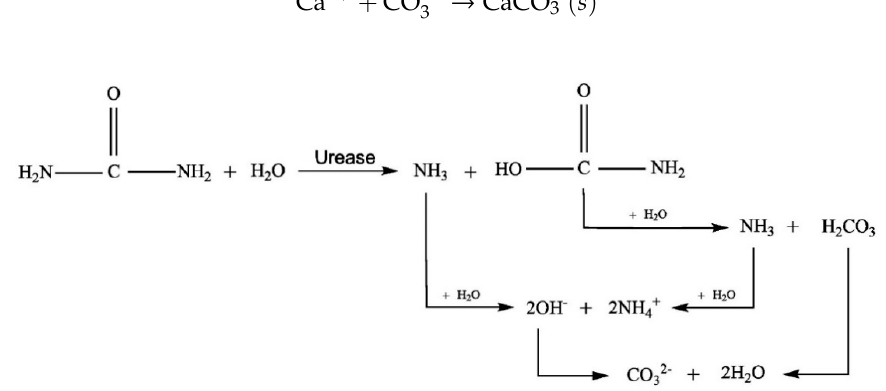
Figure 1. Schematic reactions representing the hydrolysis of urea by the urease enzyme